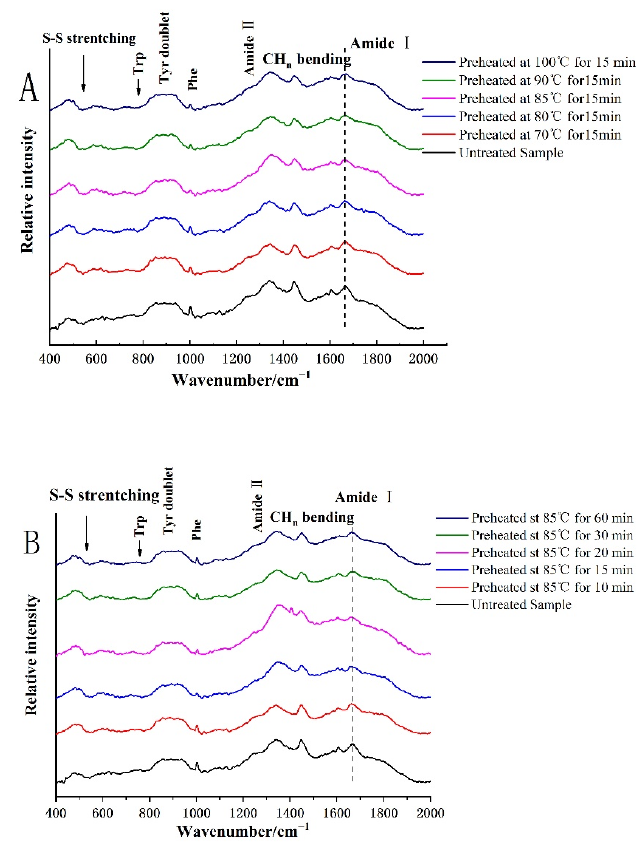
Figure 3. Raman spectra of in vitro digestion products of SPI treated at different ( A ) temperatures and ( B ) times.